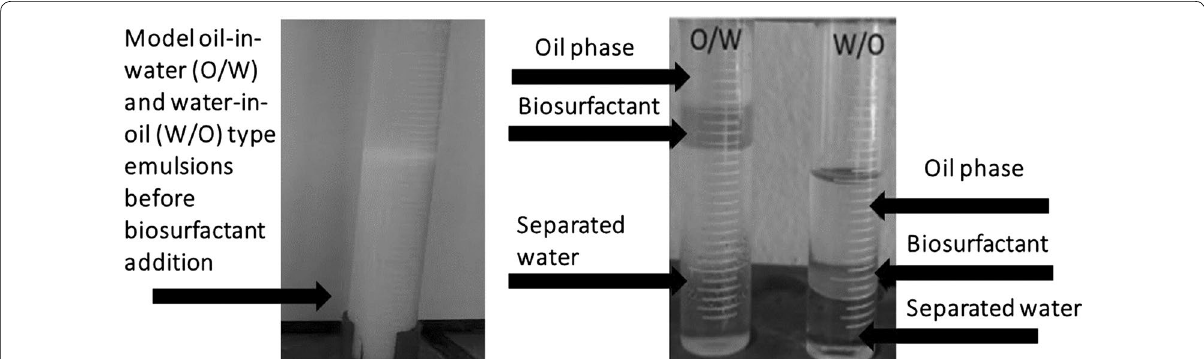
Fig. 2 Phases separation in W/O (Tween–kerosene) and O/W (Span–Tween–kerosene) model emulsions after addition of the biosurfactant from C. sphaerica